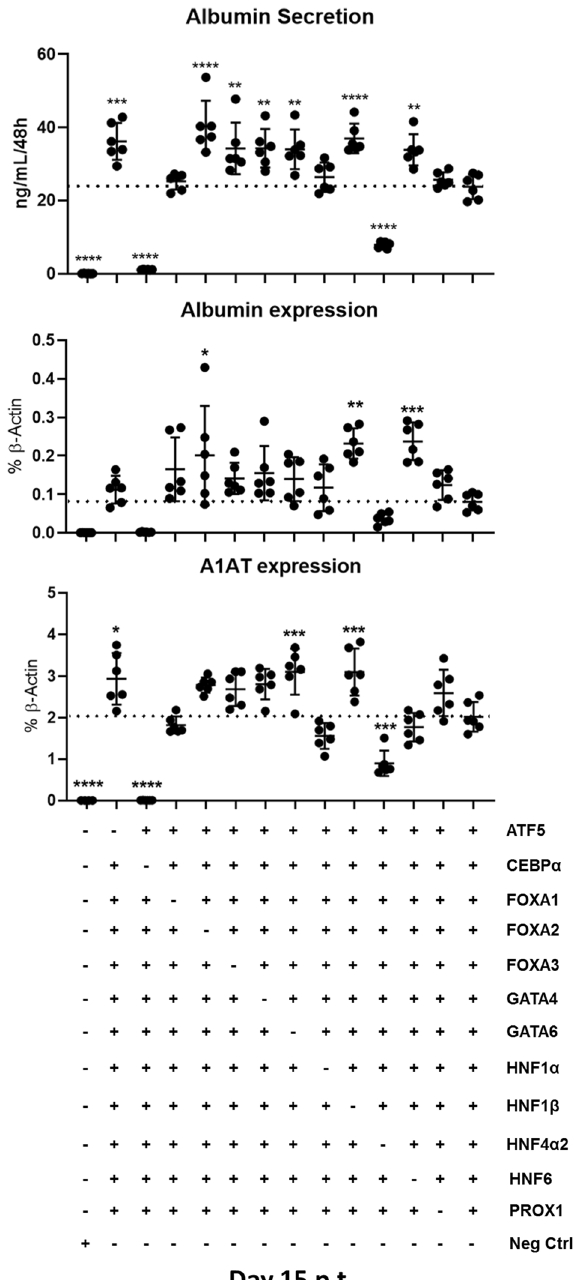
Figure 2. First step of transcription factor screening in PKFs. Albumin secretion (upper panel), ALBUMIN and A1AT gene expression levels (medium and lower panel, respectively) in PKFs transduced with 12 TFs minus one factor at a time (12-1 TF), compared to Neg-Ctrl. The dotted lines represent average values of 12 TFs replicates. All data were analyzed using one-way ANOVA, with Tukey’s post-test. Significance from n = 6 independent values is displayed as *p < 0.05; ****p ≤